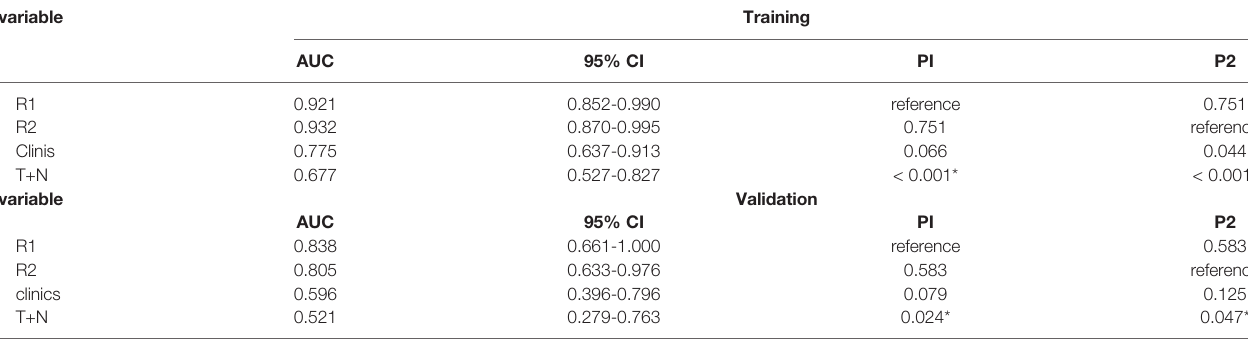
TABLE 5 | The AUC value of clinical characteristics and radiomics model.